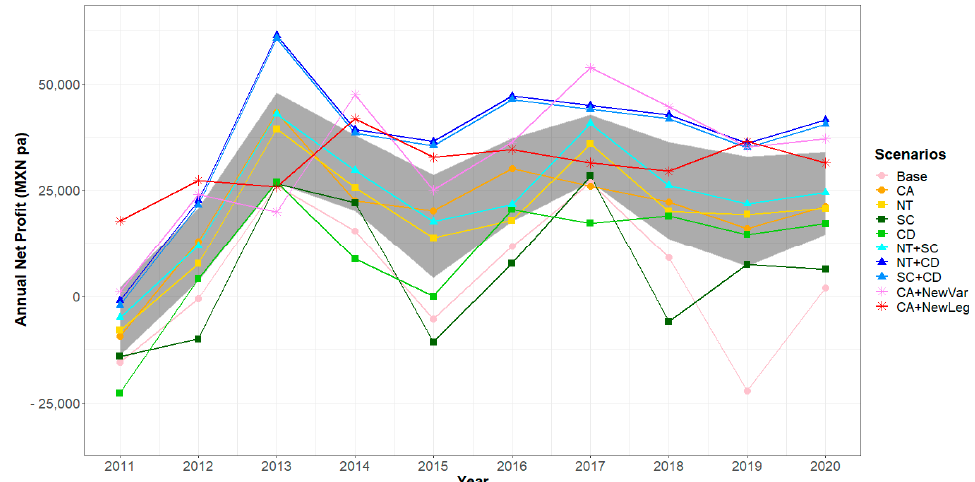
Figure 3. IAT-simulated annual farm net profit in the 10-year period of 2011–2020 for the baseline and all innovation scenarios analysed for the representative farm (T6) in southern Guanajuato, with 95% confidence band marking in gray, assuming a t-distribution of scenario estimates per year as a sample of a larger population of observations (df = 9).